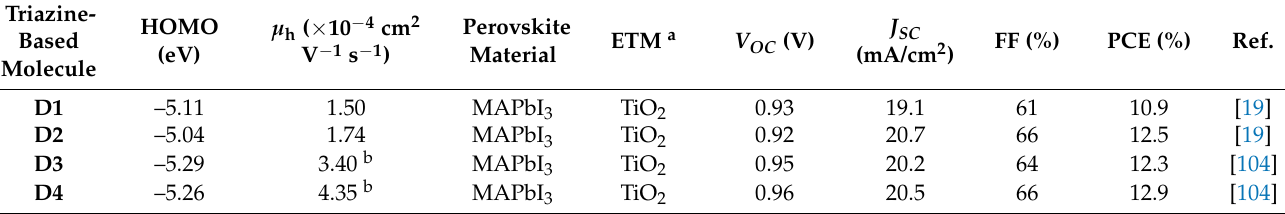
Table 4. Photovoltaic parameters of PSCs based on triazine-based molecules as HTMs.